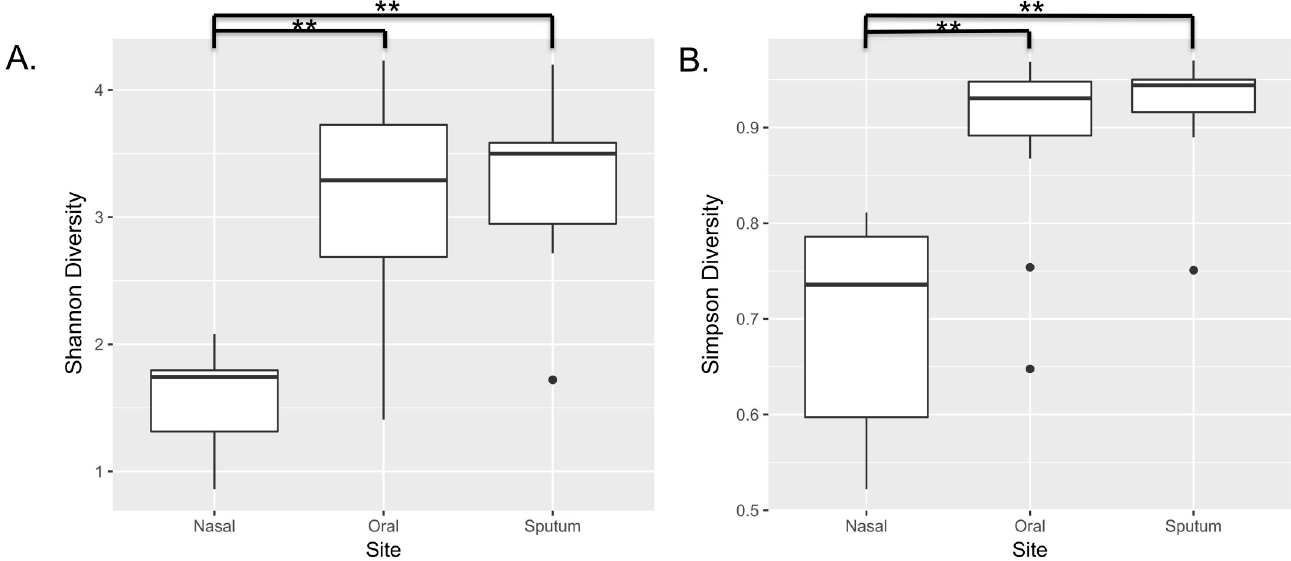
Fig 3. Alpha diversity is associated with site. Shannon and Simpson diversity were determined and the results were evaluated by site. There were 9 nasal samples, 28 oral samples (combined oral wash 1 and 2) and 13 sputum samples from 15 subjects. A) Nasal samples were least diverse, with a mean Shannon index of 1.57, followed by oral samples with a mean Shannon index of 3.19, and sputum samples with a mean Shannon index of 3.31. A linear mixed model including patient- level random effects revealed significant differences in Shannon diversity with respect to site ( p < 0.001). Paired t -tests with Benjamini-Hochberg adjustment were used to evaluate the relationship between sites, revealing significant differences between the nasal-oral sites and nasal-sputum sites (both p -values < 0.001), while there was not a significant difference between sputum and oral wash sites ( p = 0.91). B) Nasal samples were least diverse, with a mean Simpson index of 0.70, followed by oral samples with a mean Simpson index of 0.91, and sputum samples with a mean Simpson index of 0.92. A linear mixed model patient-level random effects revealed significant differences in Simpson diversity with respect to site ( p < 0.001). Paired t -tests with Benjamini-Hochberg adjustment were used to evaluate the relationship between sites, revealing significant differences between the nasal-oral sites and nasal-sputum sites (both p -values < 0.001), while there was not a significant difference between sputum and oral wash sites ( p = 0.67). To evaluate potential clinical predictors of alpha diversity, a permutation test with a general linear model was performed. Age, FEV1pp, current tobacco use, and edentulous state were individually included with site as predictors. P -values were FDR adjusted. For both Shannon and Simpson diversity models, only anatomic site was a significant predictor of alpha diversity.